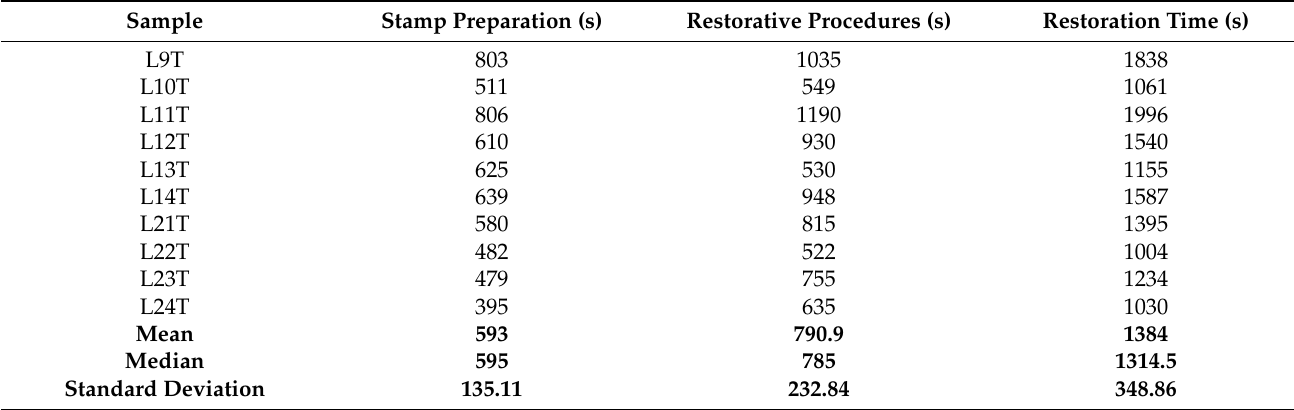
Table 10. Restoration time data in the control